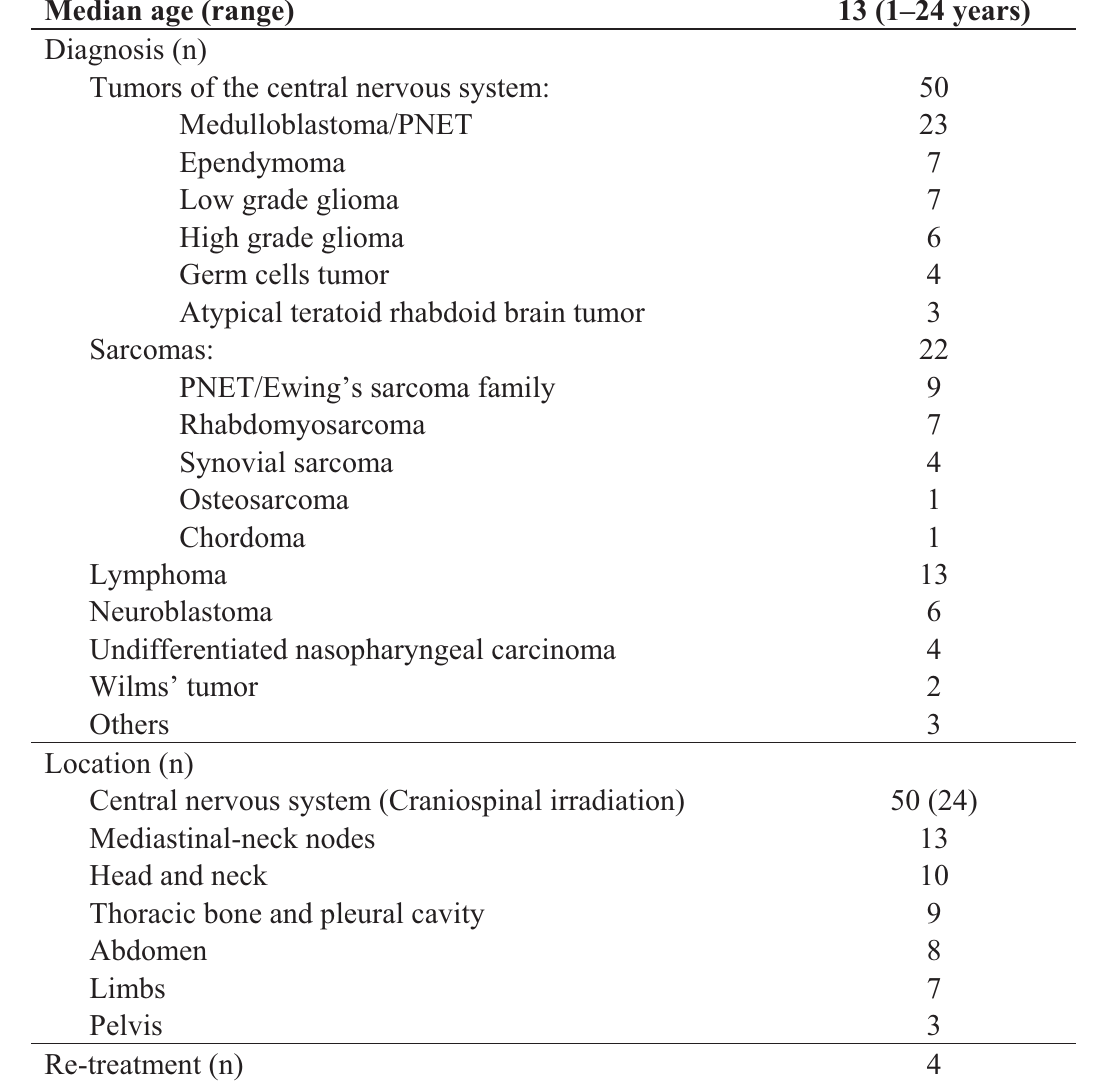
Table 1. Patients’ characteristics: age at the time of RT, histologies, site of primary tumor, re-treatments. Median age